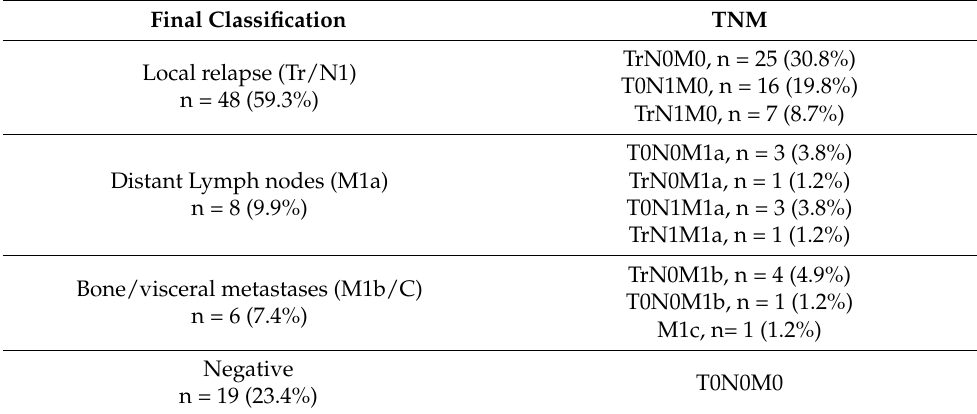
Table 2. PET/CT results classified according to PROMISE applied to 18 F-FACBC.